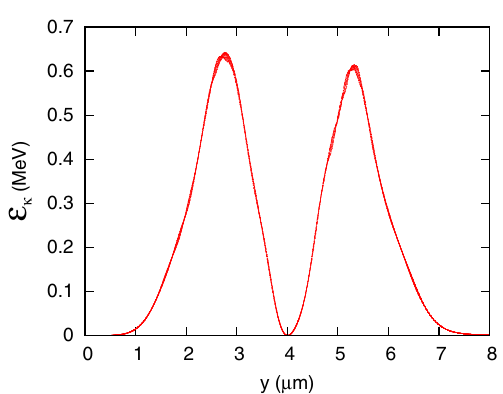
FIG. 10. Thefinalkineticenergydistribution(atinstant 21 T protons versus the transversal position y for the interaction with ¼ 0 : 6 ) introduced at the left single laser pulse ( (cid:1) 1